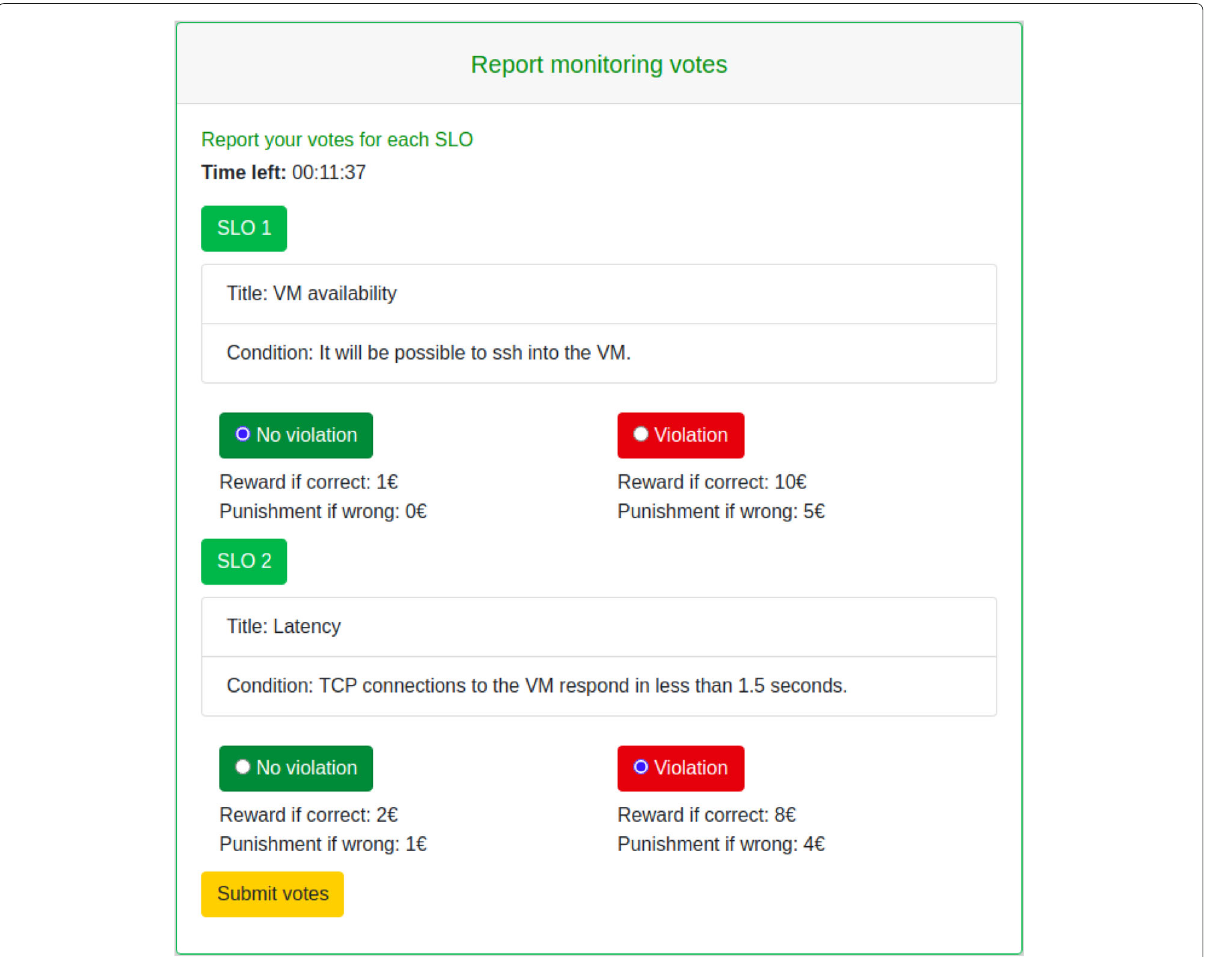
Fig. 11 Witness UI: A witness starts to submit the report for SLA violations